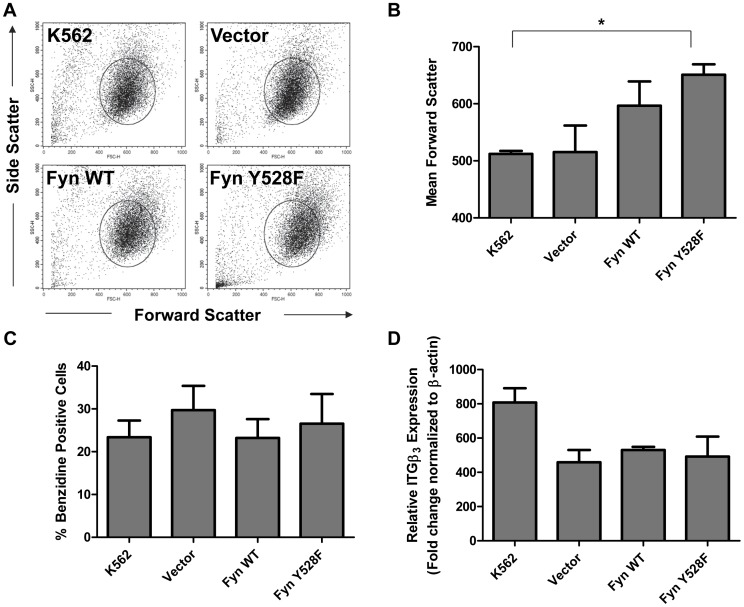
Increased size of constitutively active Fyn overexpressing cells is not a result of differences in differentiation.(A) Forward and side scatter dot plots were used to determine changes in cell size and granularity, respectively, among the K562 cells transduced with vector, wild-type (Fyn WT), and constitutively active Fyn (Fyn Y528F). The circle represents the live cell population for K562 cells. Data are representative of three independent experiments. (B) Graphical representation of the mean forward scatter values obtained from the live cell population from the dot plots in A. *p<0.05, n = 3, mean+SEM. (C) Fyn expressing K562 cells were treated with 40 µM hemin for 72 hours. Erythroid differentiation was determined by benzidine staining and the number of positive cells was counted by light microscopy. A minimum of 200 cells per condition were counted. n = 3, mean+SEM. (D) Fyn expressing K562 cells were treated with 10 nM PMA for 72 hours and RT-qPCR was performed to evaluate the level of integrin β3 (ITGβ3) expression. Ct values are normalized to β-actin and fold change is relative to the expression of ITGβ3 in untreated K562 cells. Each sample was run in duplicate. n = 2, mean+SEM.